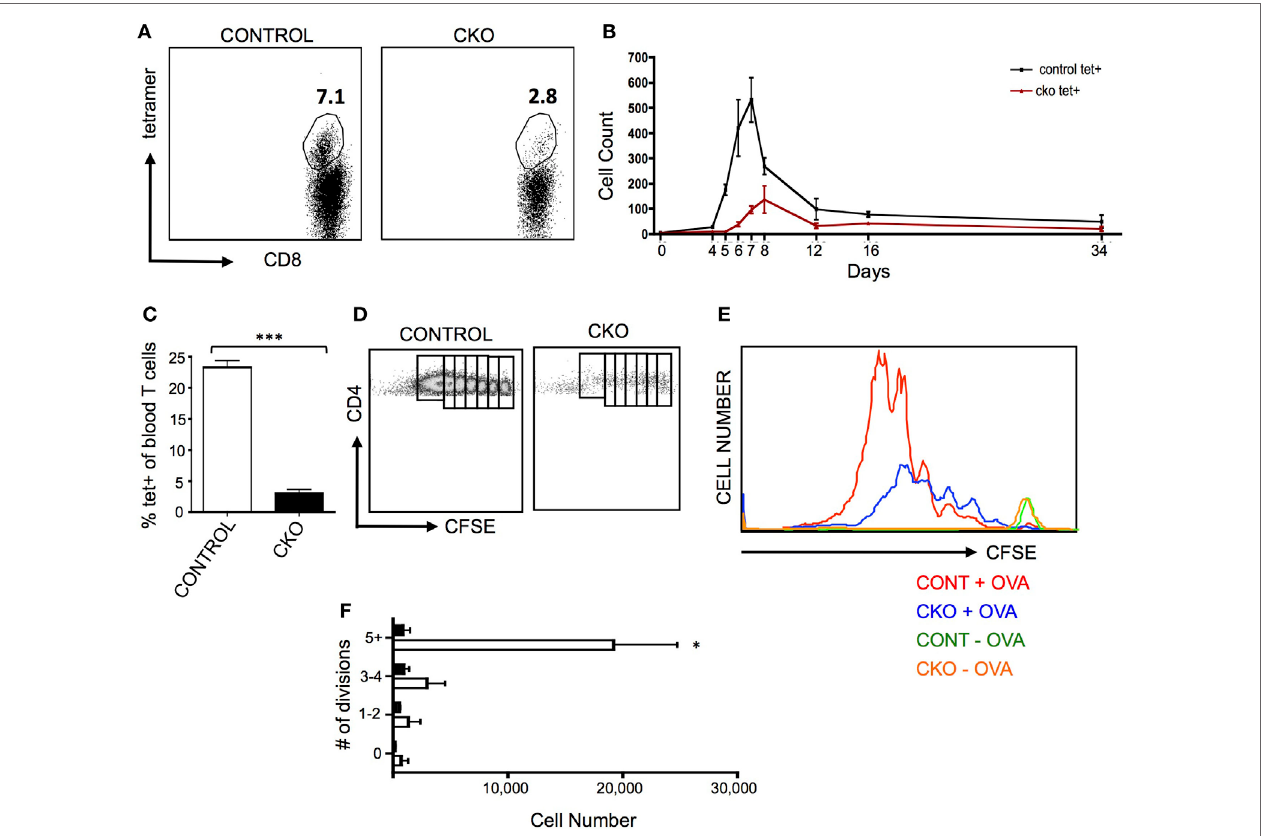
FigUre 3 | Zfx-deficient T cells fail to proliferate in response to antigen stimulation in vivo . (a) Percentage of antigen-specific CD8 + cells in the peripheral blood after infection with LM-OVA. Control and conditional knockout (CKO) mice were intravenously injected with approximately 5,000 LM-OVA and tetramer + cells were tracked in the blood. Shown is a FACS plot of CD8 + cells that are tetramer + in the blood at d7 postinfection. Number represents percentage of tetramer + cells in the CD8 + cell population. (B) Expansion of antigen-specific CD8 + cells after injection of LM-OVA. Shown is the absolute number of tetramer + cells in the blood over the course of LM-OVA infection. Values represent number of tetramer + cells ± SEM per 100,000 live white blood cells from control ( n = 3, black line) and CKO ( n = 3, red line) mice. Representative of more than five experiments. (c) Proliferation of transferred transgenic OT-I cells 5 days after exposure to LM-OVA. 500 control or CKO OT-I cells were transferred into lymhoreplete syngeneic recipients and 1 day later infected with LM-OVA. Shown is the percentage of tetramer + cells ± SEM in the blood at day 5. *** P < 0.001. (D) Expansion of transgenic OT-II cells. 5 × 10 6 carboxyfluorescein succinimidyl ester (CFSE)-labeled control and CKO cells were intravenously injected into syngeneic lymphoreplete recipients, and 1 day later, the mice were injected intraperitoneally with complete Freund’s adjuvant with ovalbumin (CFA-OVA). Shown is CFSE dilution at day 3 post CFA-OVA administration. Data are representative of three independent experiments. (e) Quantification of expanded cell populations. Shown is the dilution of CFSE versus the absolute number of cells at each stage of CFSE dilution, for control + CFA-OVA (red), CKO + CFA-OVA (blue), control without CFA-OVA (orange), and CKO without CFA-OVA (green). (F) Quantification of splenic T cells at each stage of cell division 3 days after CFA-OVA administration. Shown is absolute number of OTII T cells in the spleen ±